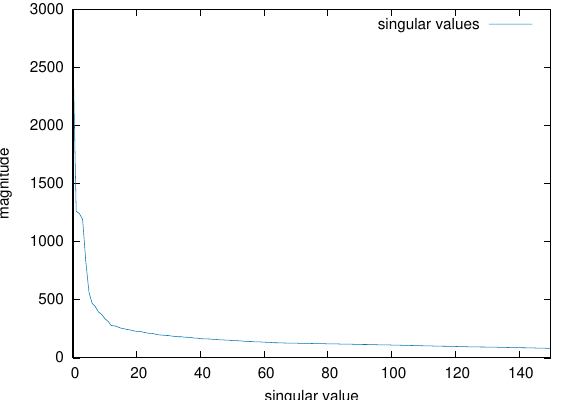
Figure 5. Singular value magnitude of an example input matrix, limited to the first 150